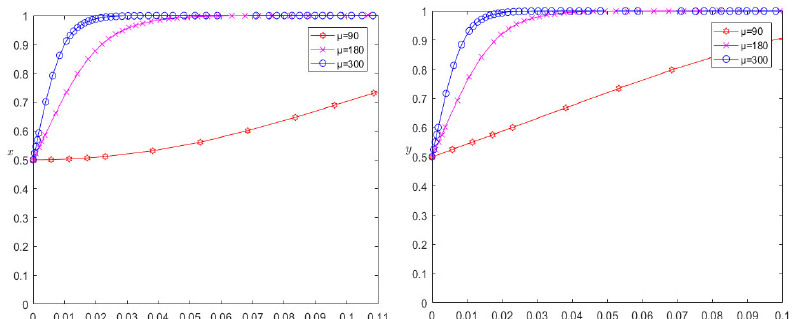
Figure 6. Evolution results of changing liquidated damages.